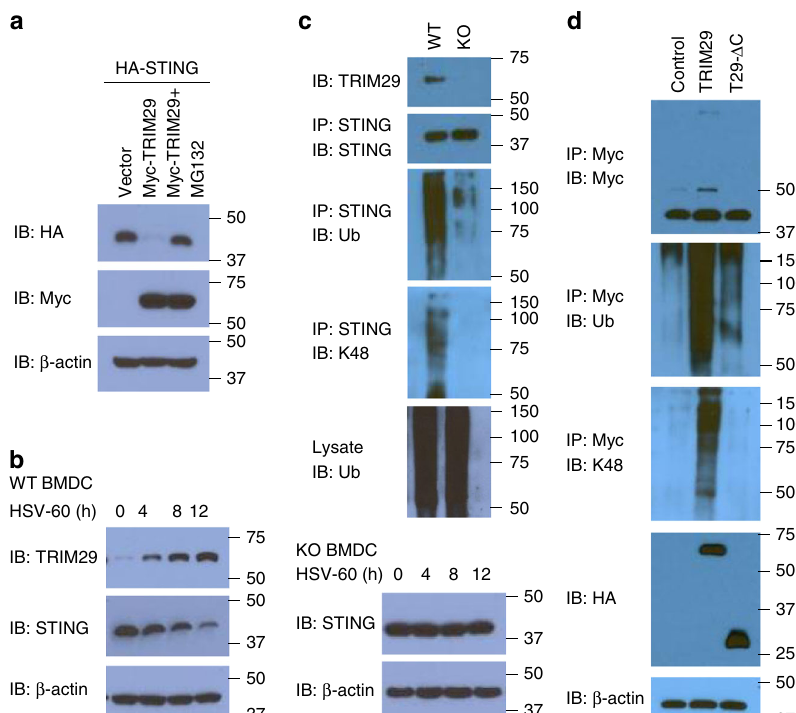
Fig. 7 TRIM29 induces ubiquitination of STING by K48-linkage. a Immunoblot analysis of HA-tagged STING ( top blot ), Myc-tagged TRIM29 ( middle blot ), and β -actin ( bottom blot ) in HEK293T cells co-transfected with expression vector for HA-tagged STING and with empty vector or expression vector for Myc-tagged TRIM29, with or without treatment of 5 μ M MG132 ( above lanes ). b Immunoblot analysis of TRIM29 ( top blot ), STING ( middle blot ), and β -actin ( bottom blot ) in both WT and TRIM29 KO BMDCs stimulated for various times ( above lanes ) with HSV-60 (2.5 μ g/ml). c Immunoblot analysis of TRIM29 in WT and KO BMDCs ( top ), and of the abundance ( second blot ), total ubiquitination ( third blot for IP, bottom blot for lysate ), and K48-mediated ubiquitination ( fourth blot ) of STING in those cells, stimulated for 4 h with HSV-60 (2.5 μ g/ml), assessed after immunoprecipitation with anti-STING. d Immunoblot analysis (with anti-Myc) of the abundance ( top ), total ubiquitination ( second blot ), and K48-linked ubiquitination ( third blot ) of Myc-tagged STING in HEK293T cells transfected with empty vector or expression vector for HA-tagged TRIM29, truncation T29- Δ C (losing binding site of STING), and stimulated for 4 h with HSV-60 (2.5 μ g/ml), assessed after immunoprecipitation with anti-Myc; immunoblot analysis of whole-cell lysates with anti-HA ( fourth blot ) and anti- β -actin ( bottom ). The position of protein markers (shown in kDa) is indicated on the right . Data are representative of three